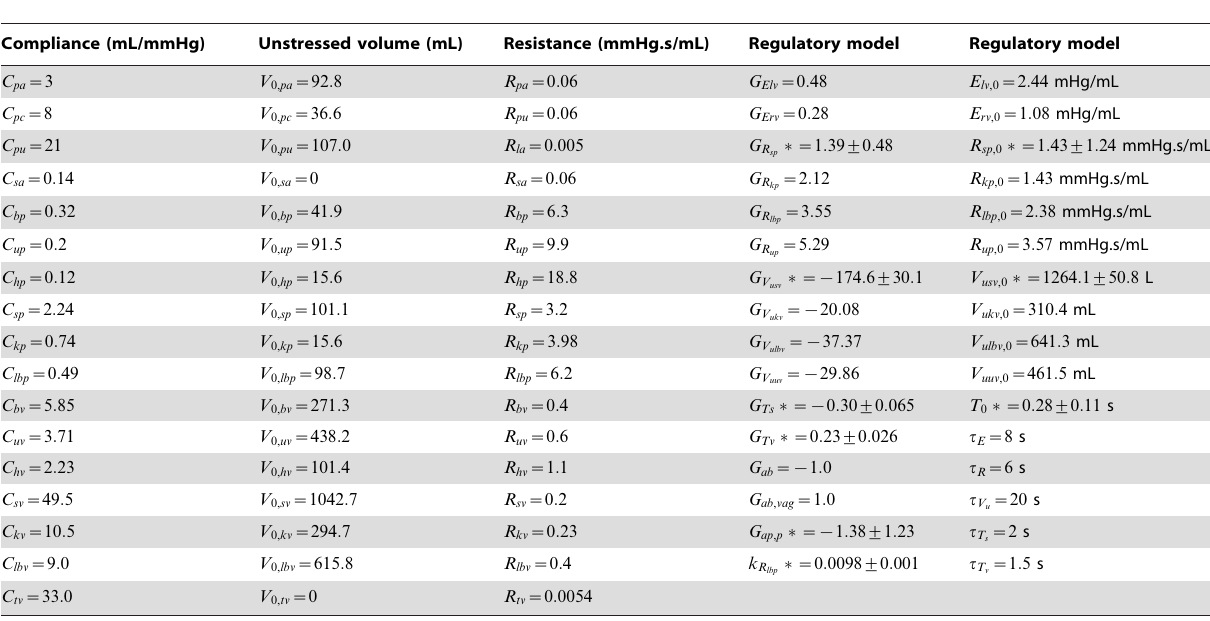
Table 2. Values of the model parameters characterizing the circulation and regulatory